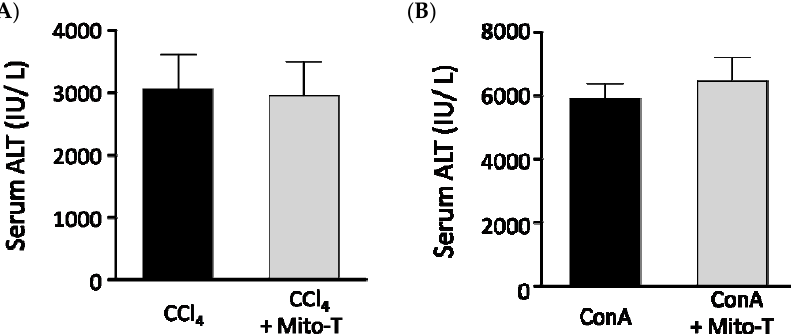
Figure 6. E ff ect of Mito-T on serum ALT levels in mice administered CCl 4 or ConA. Mice were treated with Mito-T (20 mg / kg, i.p.) 1 h after CCl 4 (0.025 mg / kg, i.p.) or ConA (12.5 mg / kg, i.v.) administration. The serum ALT activity was measured 24 h after CCl 4 ( A ) or ConA ( B ) injection. Each value represents the mean ± SEM ( n =